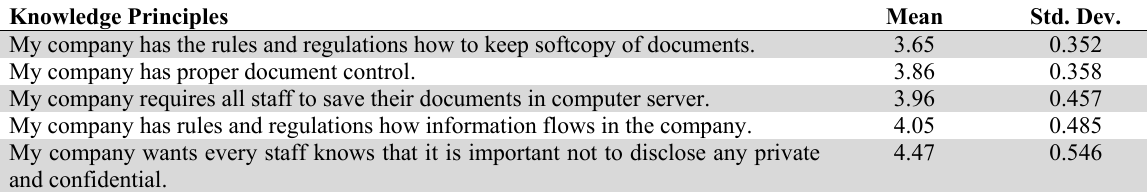
Mean and Standard Deviation for “Knowledge Principles” Knowledge Principles